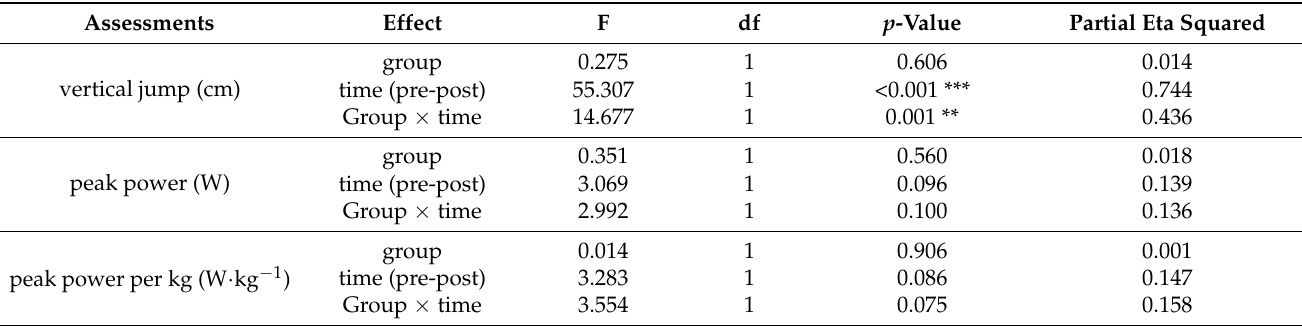
Table 4. Two-way ANOVA of vertical jump and peak power